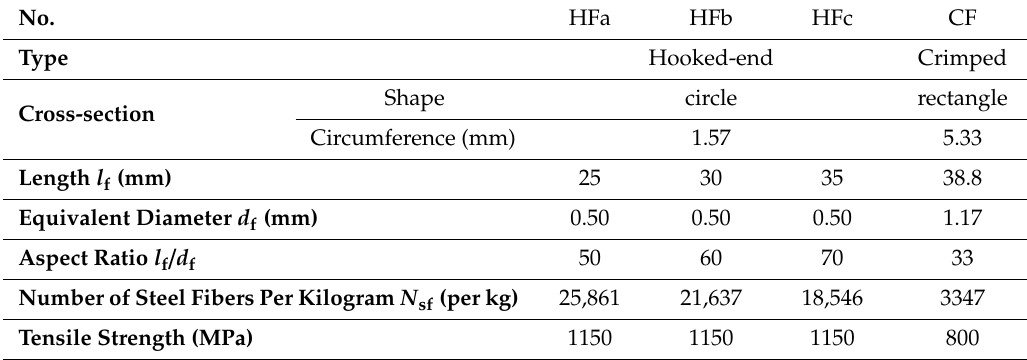
Table 1. Physical and mechanical properties of steel fibers. HF, hooked-end steel fiber; CF, crimped steel fiber.